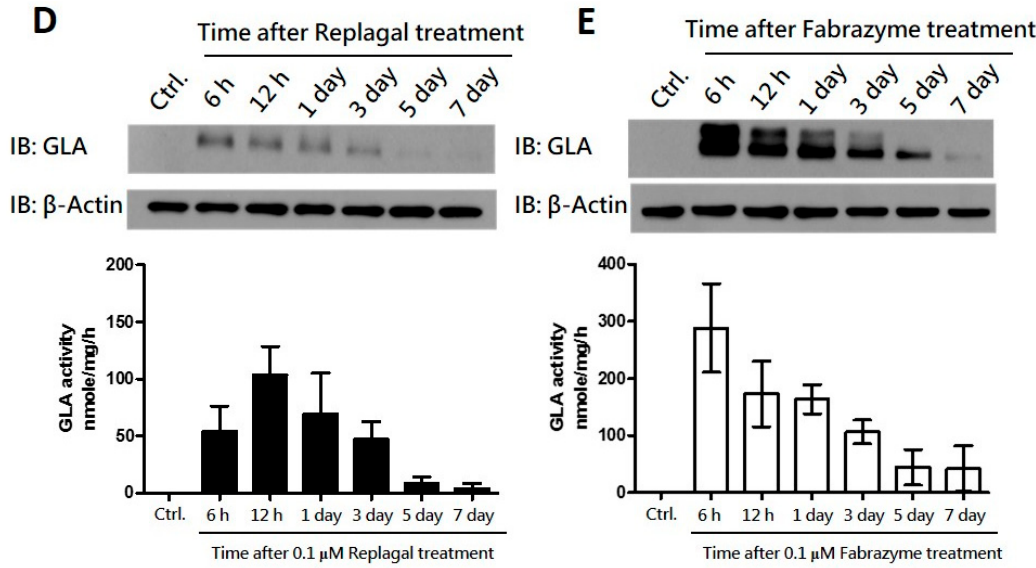
Figure 2. Enzyme activity and protein expression of rh α -GLA in the GLA-null cell lines. The CRISPR/Cas9-mediated GLA-null HEK-293T cell lines, i.e., clone 19 ( A ) and clone 30 ( B ) were incubated with 0.1 and 1 µM Replagal or Fabrazyme for 6 h. The GLA enzyme activities